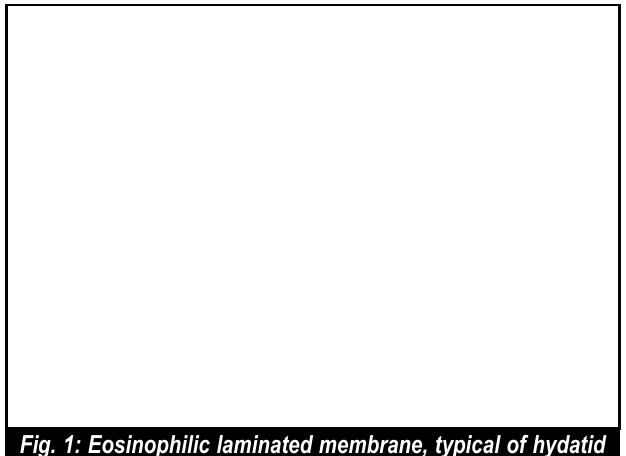
Fig. 1: Eosinophilic laminated membrane, typical of hydatid cyst. Magnification x 40. Hematoxylin & Eosin stain.